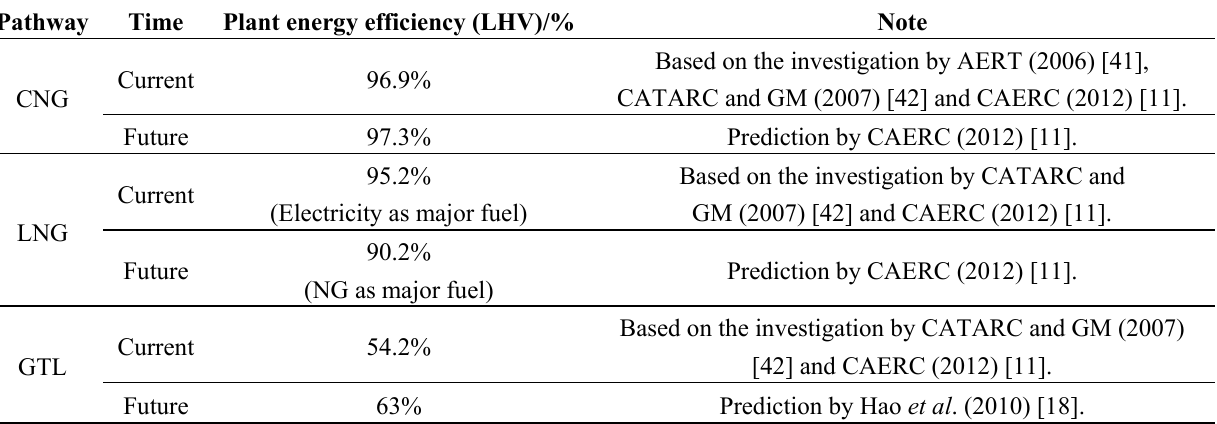
Table 3. Energy efficiency situations of each NG-based fuel